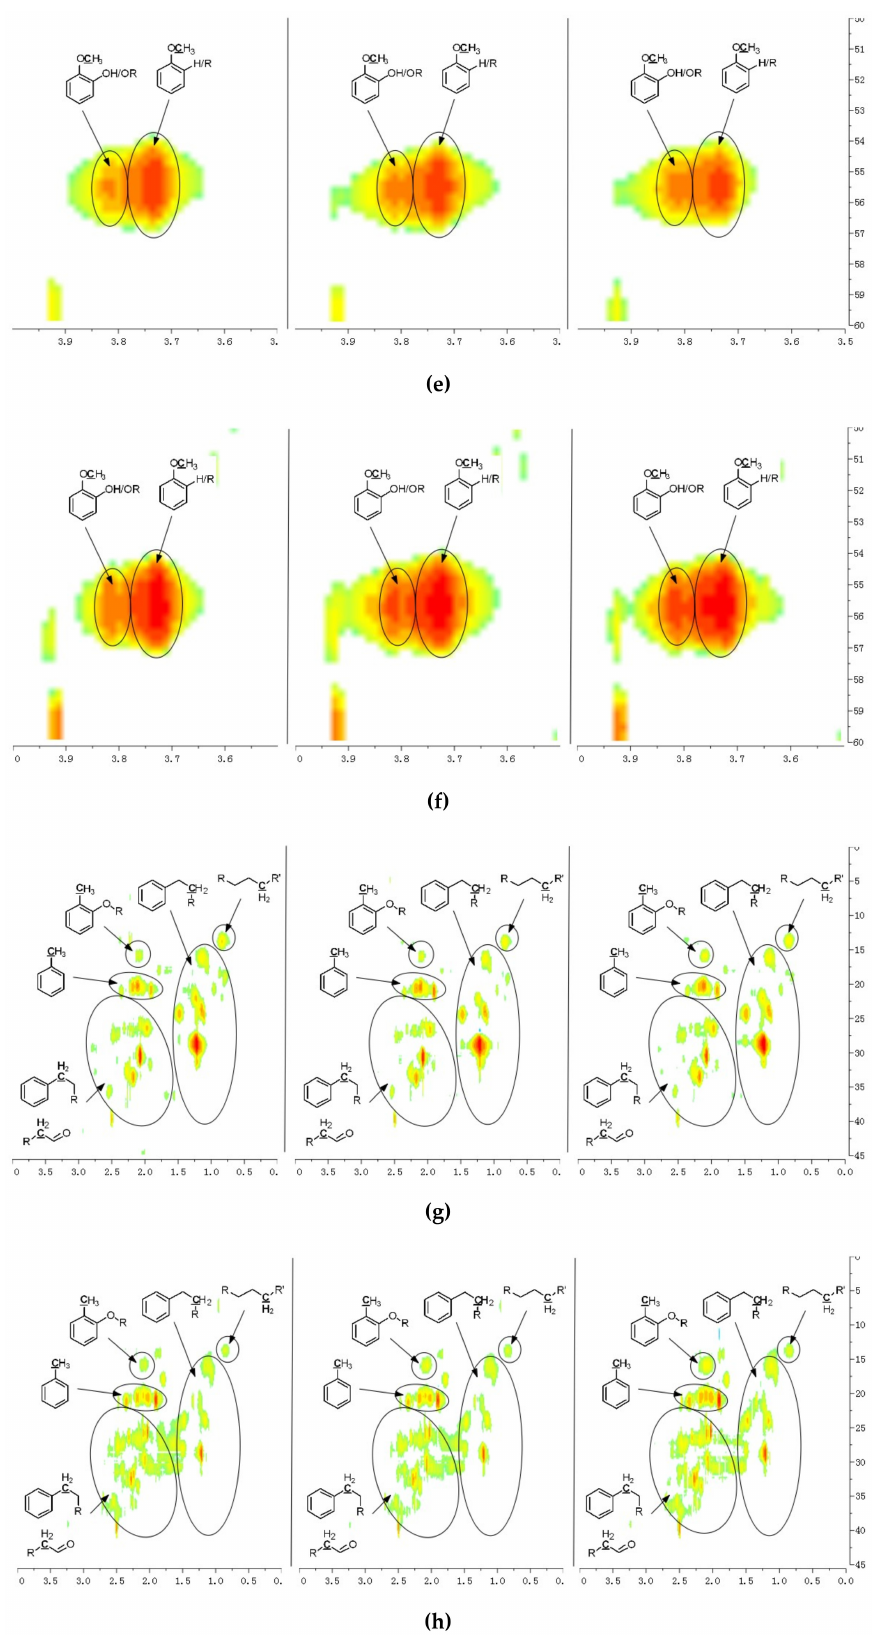
Figure 4. HSQC-NMR spectra and the assignments of each carbon in the levoglucosan present in the pyrolysis oils ( a ) produced from the pyrolysis of pine bark from 400 to 600 ◦ C (from left to